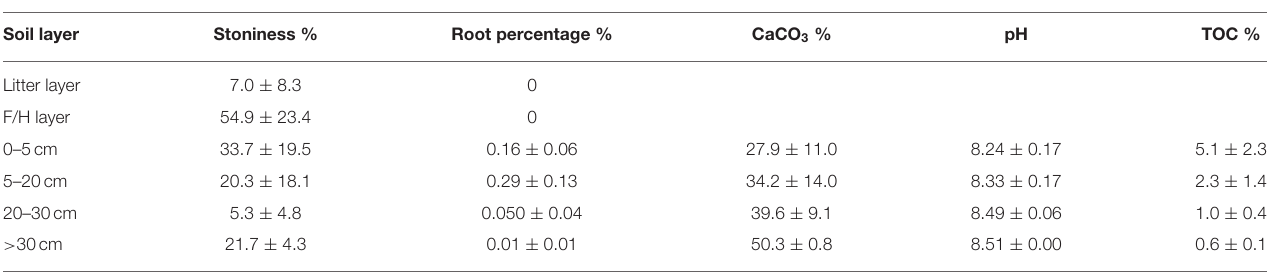
Plot Depth Presence Woody